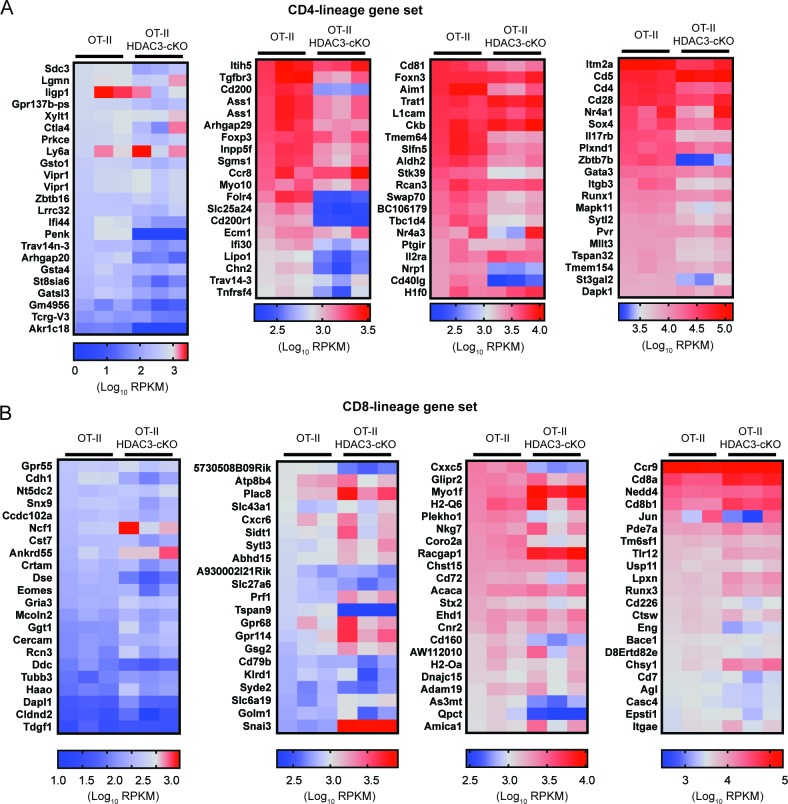
Heatmaps of CD4-lineage and CD8-lineage genes.Heatmaps depict Log10 RPKM of genes in CD4-lineage (A) and CD8-lineage (B) gene sets in Selecting (CD69+) thymocytes from OT-II and OT-II HDAC3-cKO. Heatmaps show three biological replicates per mouse group. Scale bar is below each heatmap. Refer to Figure 3—source data 1 for Log2fold change between OT-II and OT-II HDAC3-cKO mice.